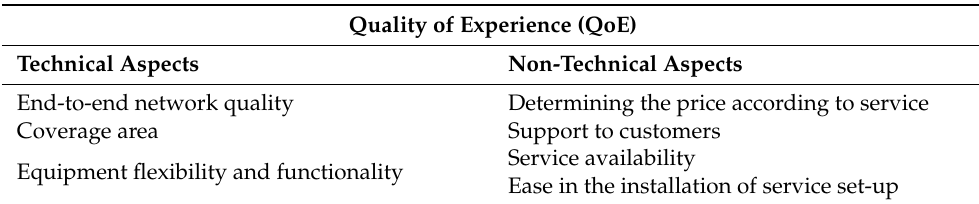
Table 5. Technical and non-technical aspect of